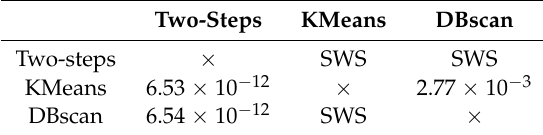
Table 23. p -values for instance f.8.